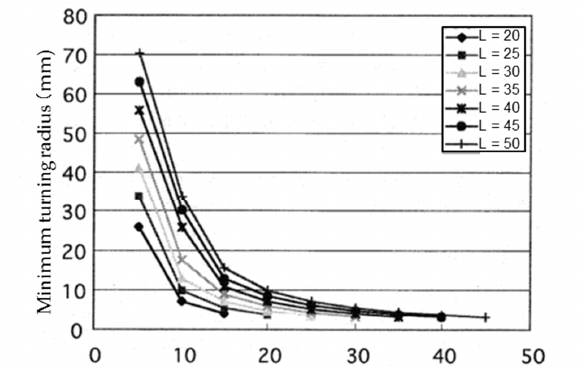
Figure 13. The relationship between the minimum turning radius and the difference in rotational frequency of the left and right driving wheels. The relationship was calculated when the rotational frequency of the left wheel was changed from 20 rpm to 50 rpm in 5-rpm increments. Because a similar tendency was observed at all rotational frequencies, the results were replotted (Figure 14) with the horizontal axis set to the ratio of the difference in frequencies to the frequency of the left driving wheel ((frequency of the left driving wheel - frequency of the right driving wheel)/frequency of the left driving wheel).